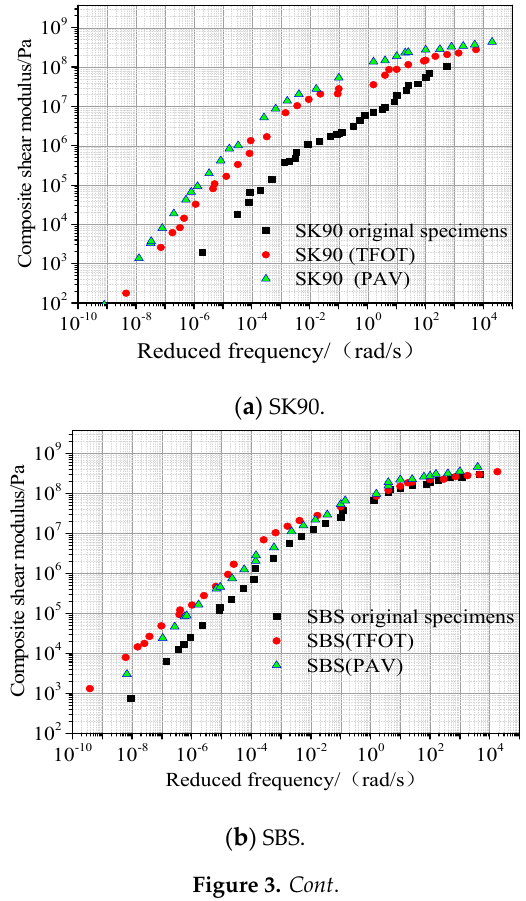
( c ) SBS/CRP. Figure 3. Master curve of composite shear modulus of asphalt: ( a ) SK90; ( b ) SBS; ( c ) SBS/CRP. In Figure 3a, the master curve of composite shear modulus of SK90 before and after aging changes a lot in the low-frequency region, which tends to cluster gradually in the high-frequency region. The effect of SK90 on the composite shear modulus in the high-frequency and low- temperature region is weakened. In Figure 3b the effect of SBS modified asphalt on the composite shear modulus is smaller, and the curve separation occurs only in the low-frequency region. In contrast, Figure 3c, three curves of SBS/CRP composite modified asphalt are the most stable during the change process of frequency. They are almost in the state of aggregation in the entire frequency range, and slightly affected by the aging. Therefore, the SBS/CRP composite modified asphalt has the best anti-aging performance. 3.2. Analysis of Low-Temperature Creep Characteristic Based on the Burgers Model The BBR test results of each specimen at different temperatures are shown in Table 5. It can be seen that, as the degree of aging deepens at the same temperature, the stiffness modulus S of asphalt increases and the creep rate m decreases. Test results of SK90 virgin asphalt, SBS modified asphalt and SBS/CRP composite modified asphalt could meet the requirements of the Strategic Highway Research Program (SHRP) specification at − 12, − 18 and − 24 °C, respectively. When the test temperature is − 30 °C, the movement of asphalt segment is limited by freezing. When the asphalt is hardened, the value S of specimens in all groups is more than 300 MPa, and the value m is less than 0.3.